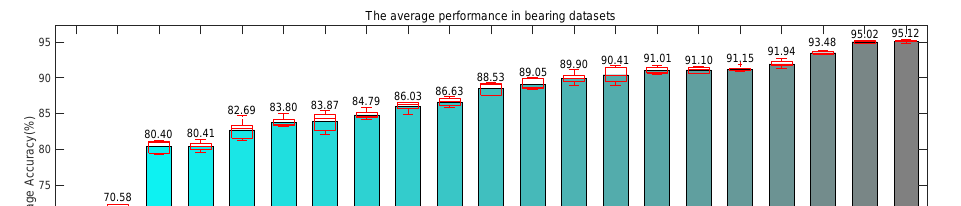
Figure 9. The results of the spindle datasets.